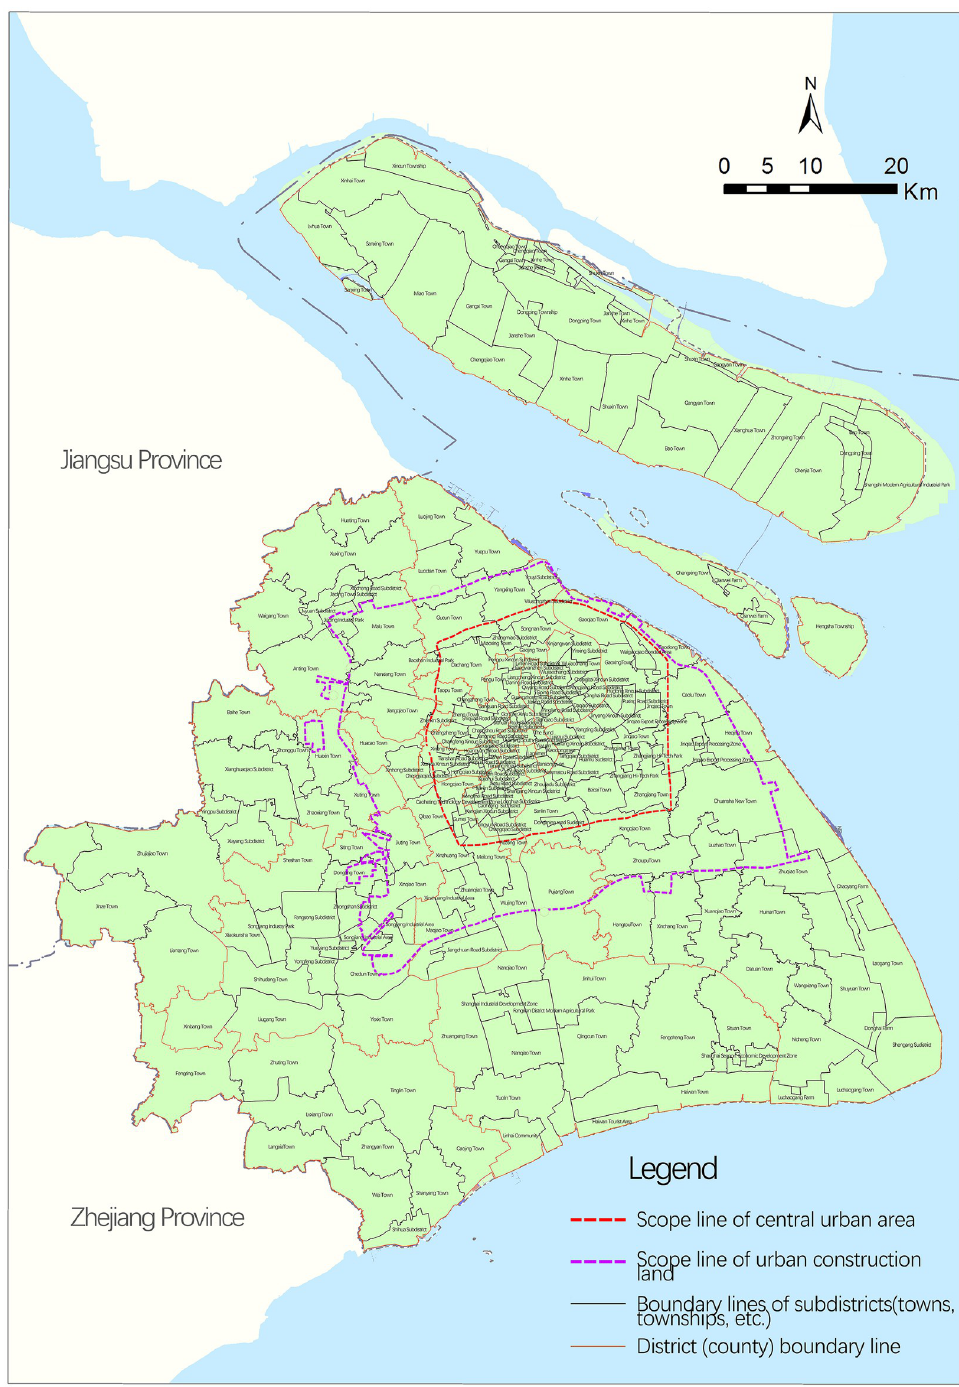
Fig 1. Division of study region. Source: Created by the author based on the base map of Shanghai from the Open Street Map(OSM) geographic data platform(https://www.openstreetmap.org/).